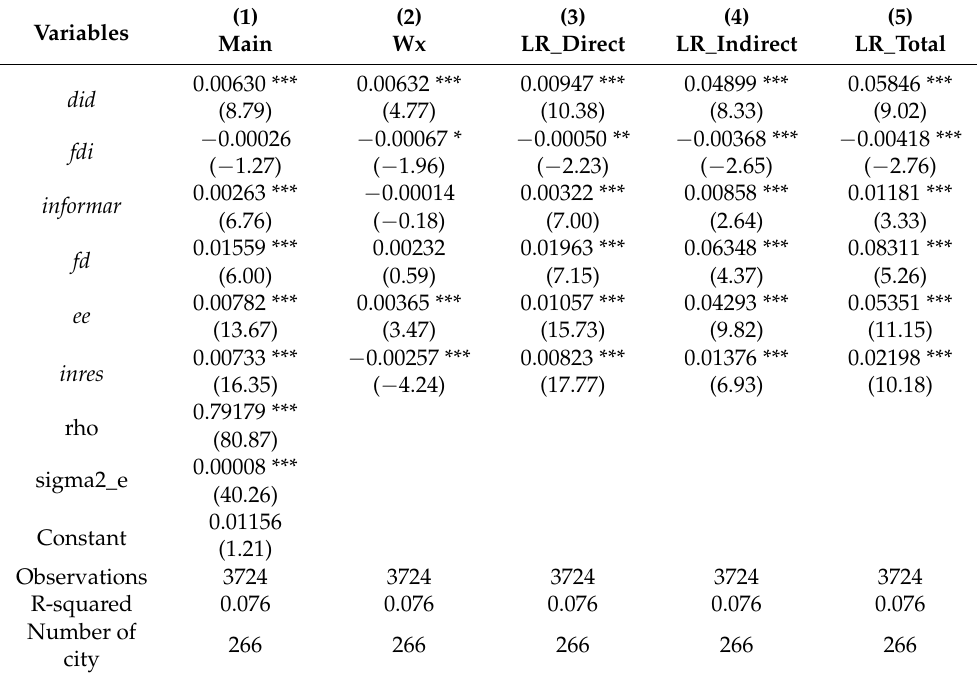
Table 10. Verification of low-carbon pilot city construction and ULGUE empirical results.